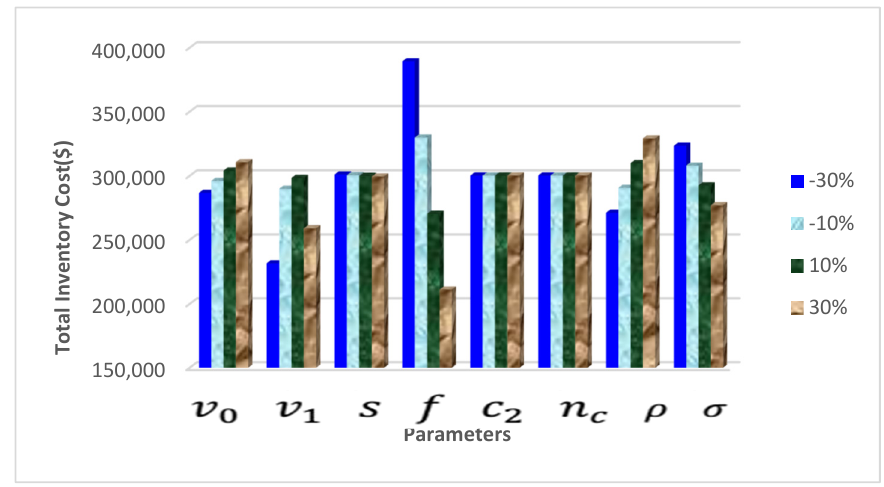
Figure 10. Sensitivity analysis of parameters.